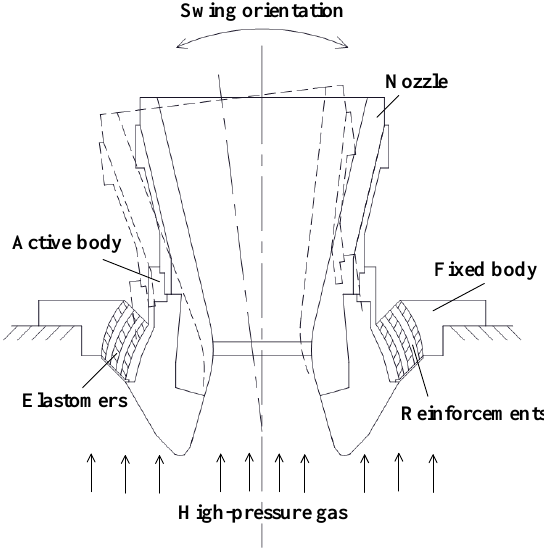
Figure 1. Swing nozzle and flexible joint.